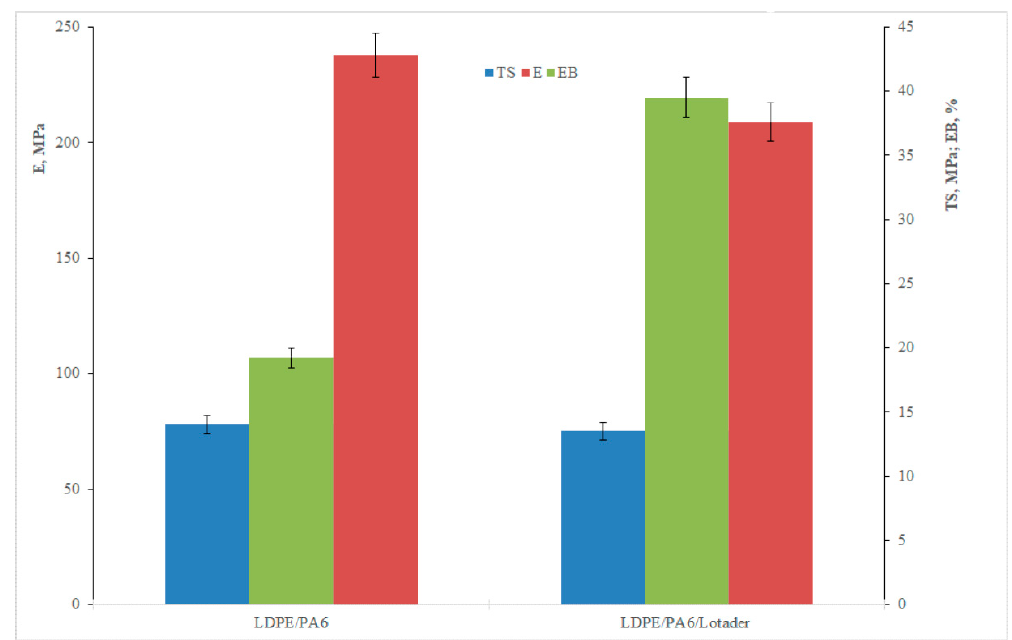
Figure 3. Tensile properties of the isotropic blends. Elastic modulus, E; tensile strength, TS; elongation at break, EB.